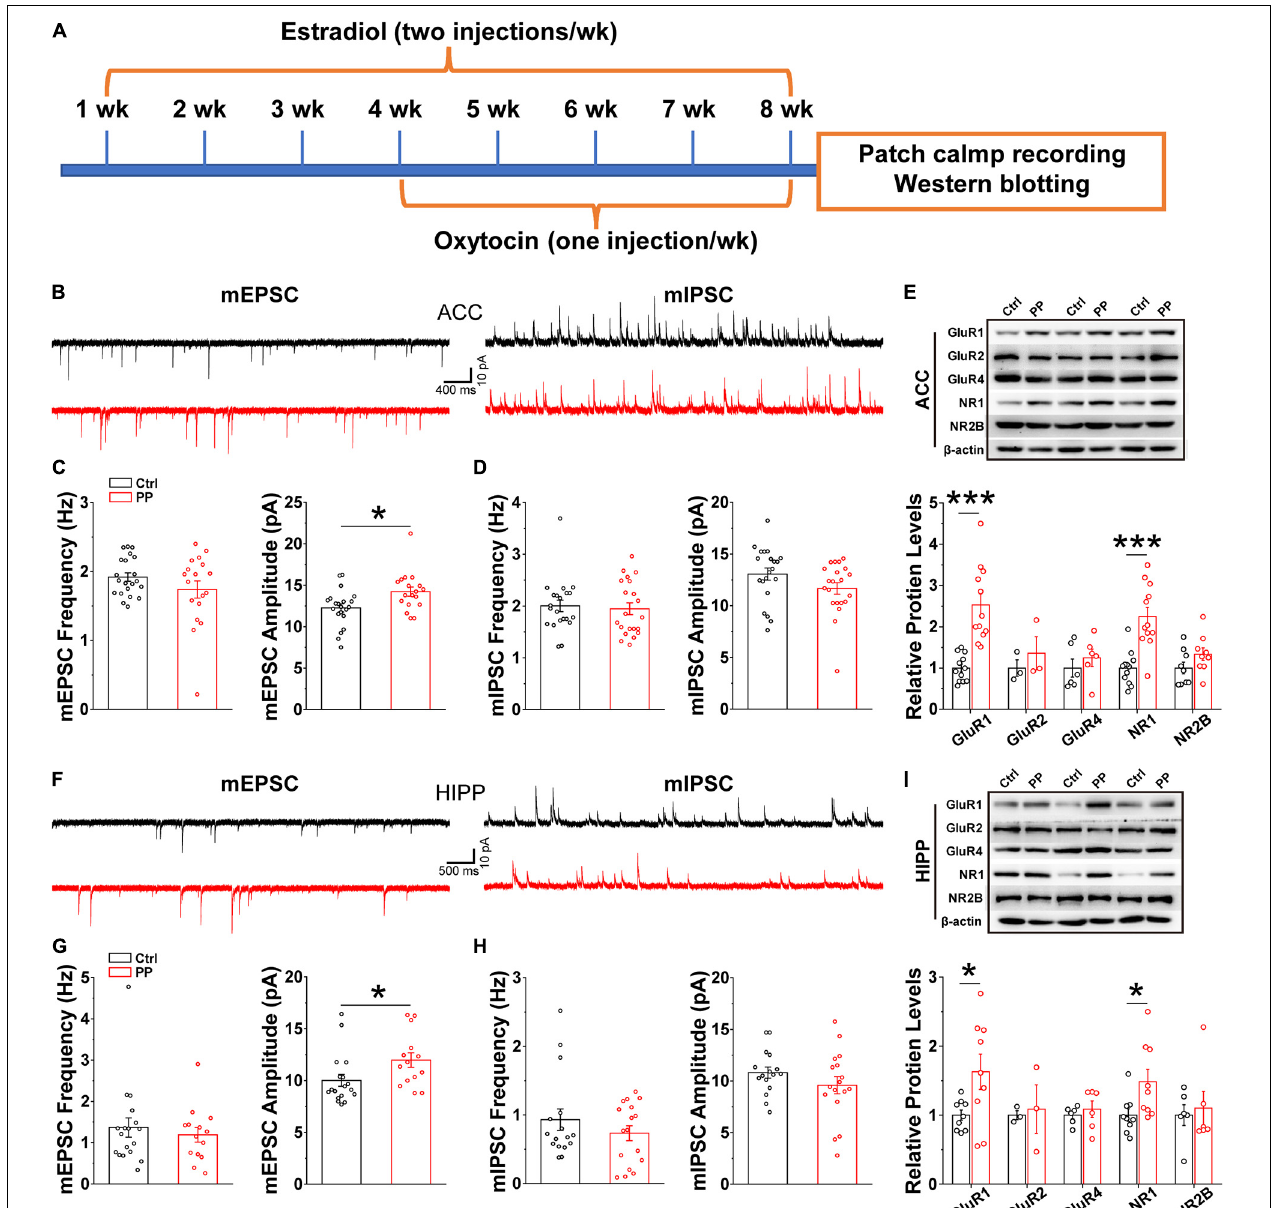
FIGURE 6 | Increased mEPSC amplitude and levels of excitatory postsynaptic receptors in model rats. (A) Diagram showing model generation and patch clamp/western blot analysis. (B) Representative mEPSC (left) and mIPSC (right) traces recorded in the ACC. (C) Statistical analysis indicating significantly increased amplitude but not frequency of mEPSCs in model rat ACC (frequency: Control, 1.92 ± 0.06 Hz, PP, 1.71 ± 0.124 Hz, p = 0.136; amplitude: Control, 12.26 ± 0.48 pA, PP, 14.22 ± 0.55 pA, p = 0.012; Control, n = 21 cells of five rats; PP, n = 18 cells of five rats). (D) Identical mIPSC frequency and amplitude in control and model ACC (frequency: Control, 2.00 ± 0.11 Hz, PP, 1.95 ± 0.11 Hz, p = 0.20; amplitude: Control,13.06 ± 0.59 pA, PP, 11.67 ± 0.55 pA, p = 0.09; Control, n = 22 cells of five rats; PP, n = 22 cells of five rats). (E) Example of immunoblots of ACC extracts probed with anti-GluR1, GluR2, GluR4, NR1, and NR2B antibodies and quantification of the immunoblots revealing significant increases in levels of GluR1 ( p = 0.014) and NR1 ( p = 0.024), but not GluR2, GluR4 and NR2B. (F) Representative mEPSC (left) and mIPSC (right) traces in the HIPP. (G) Statistical analysis showing significantly increased mEPSC amplitude, but not frequency, in model rats (frequency: Control, 1.36 ± 0.12 Hz, p = 0.23; PP, 1.31 ± 0.15 Hz, p = 0.23; amplitude: Control, 10.89 ± 0.78 pA, PP, 12.67 ± 0.84 pA, p = 0.02; Control, n = 21 cells of five rats; PP, n = 20 cells of five rats). (H) Identical mIPSC frequency and amplitude in HIPP of control and model rats (frequency: Control, 0.98 ± 0.14, PP, 0.76 ± 0.18, p = 0.43; amplitude: Control, 10.71 ± 0.53, PP, 9.82 ± 0.59, p = 0.36; Control, n = 22 cells of 5 rats; PP, n = 22 cells of five rats). (I) Example of immunoblots probed with anti-GluR1, GluR2, GluR4, NR1, and NR2B antibodies and quantification of the immunoblots revealing a significant increase in levels of NR1 ( p = 0.029). Values represent mean ± SEM. One-way ANOVA was used for mEPSCs and mIPSCs, and two-sample t -test for western blotting. * p < 0.05, *** p <